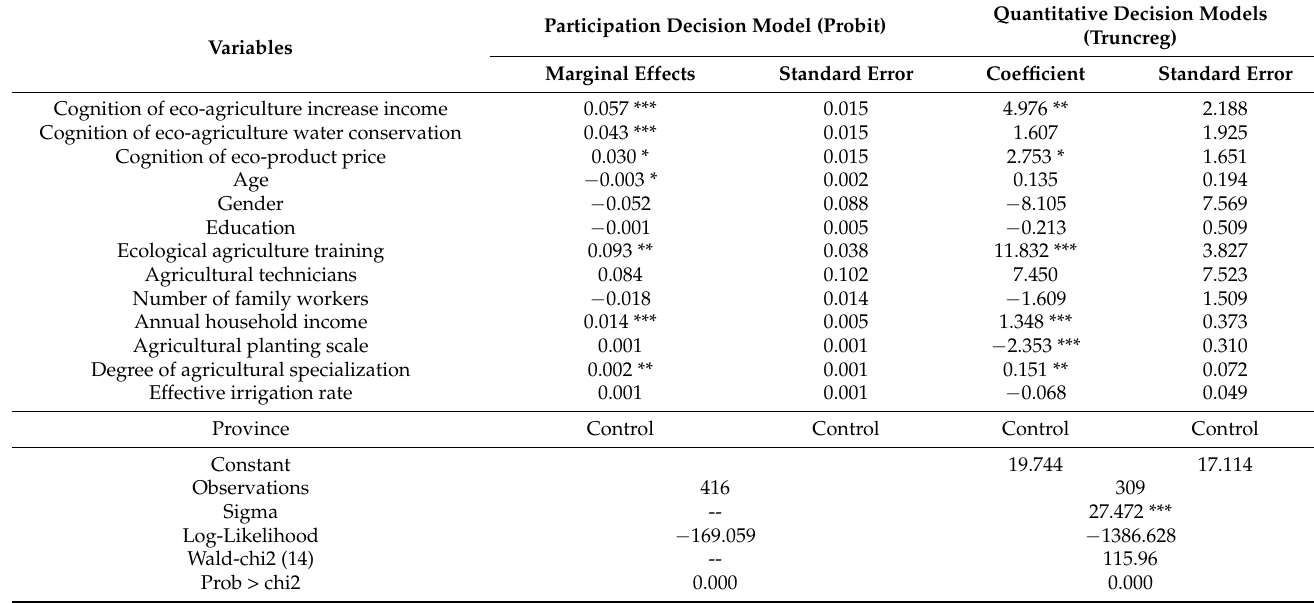
Table 2. Results of ecological agriculture cognition on farmers’ response to specialty orchard fruit planting.